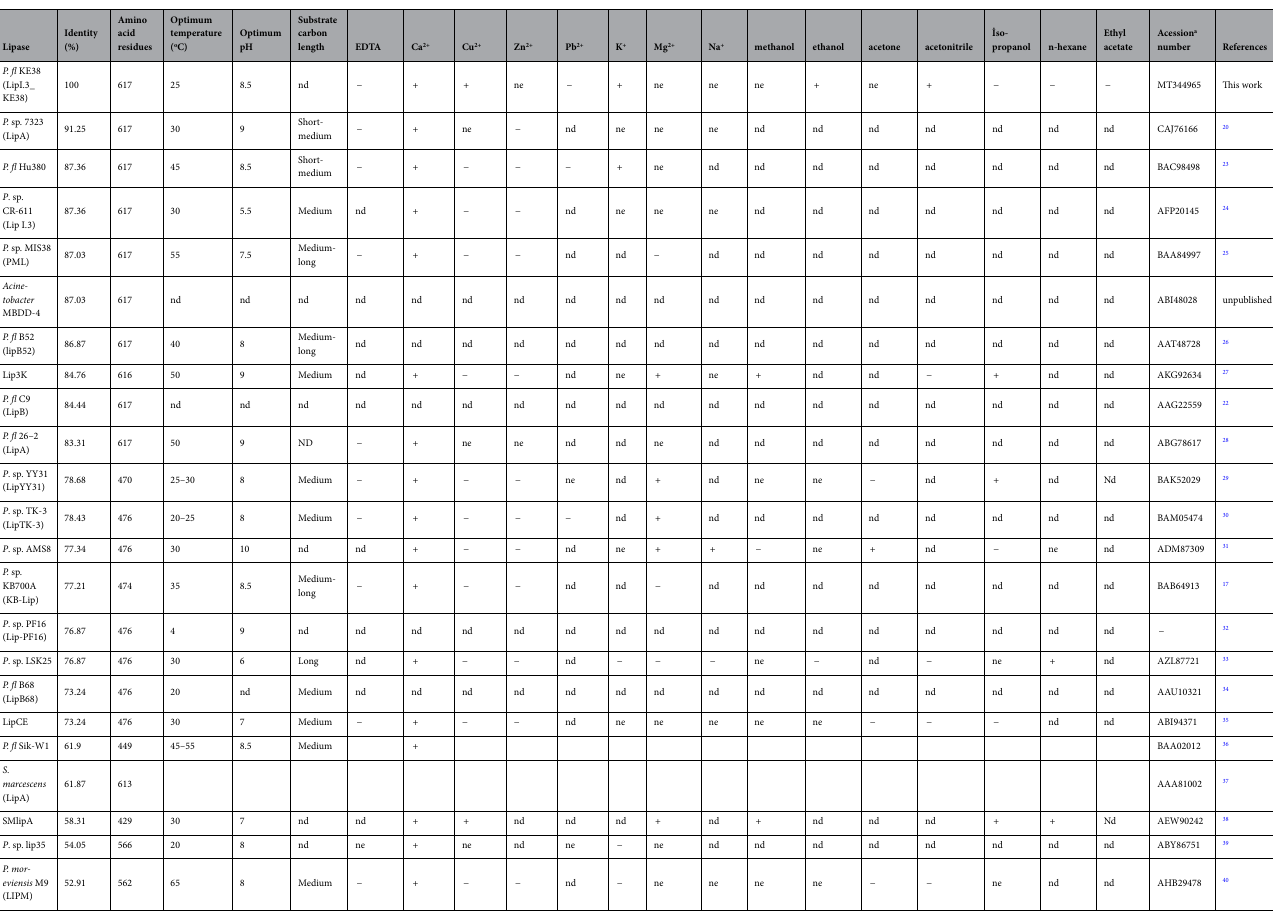
Table 1. Comparison of the properties of LipI.3_KE38 with other lipases belonging to the same family, I.3. nd not determined, ne no effect on lipase activity. a Accession numbers from NCBI database. −: negative effect on lipase activity. +: positive effect on lipase